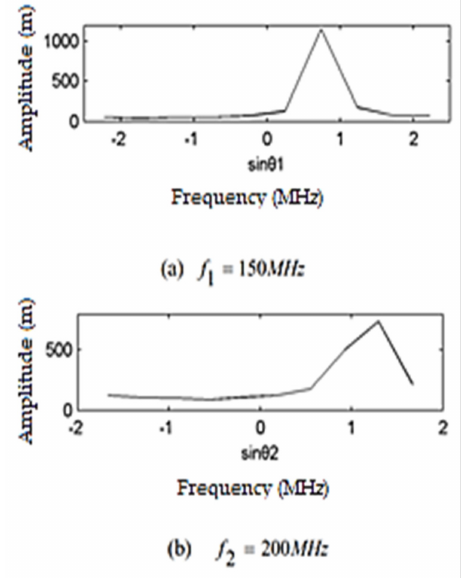
Figure 4. DOA Estimation when n = 10